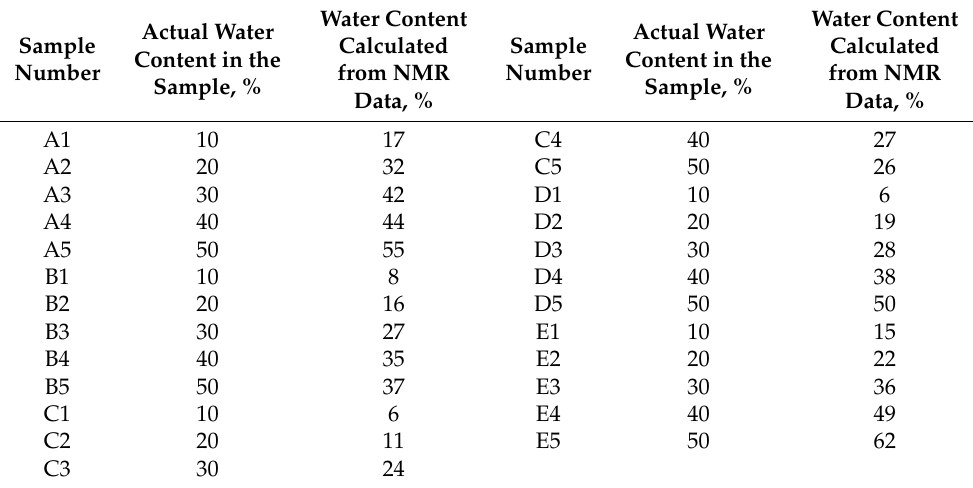
Table 4. Water content in the water–oil mixtures: actual and calculated from NMR